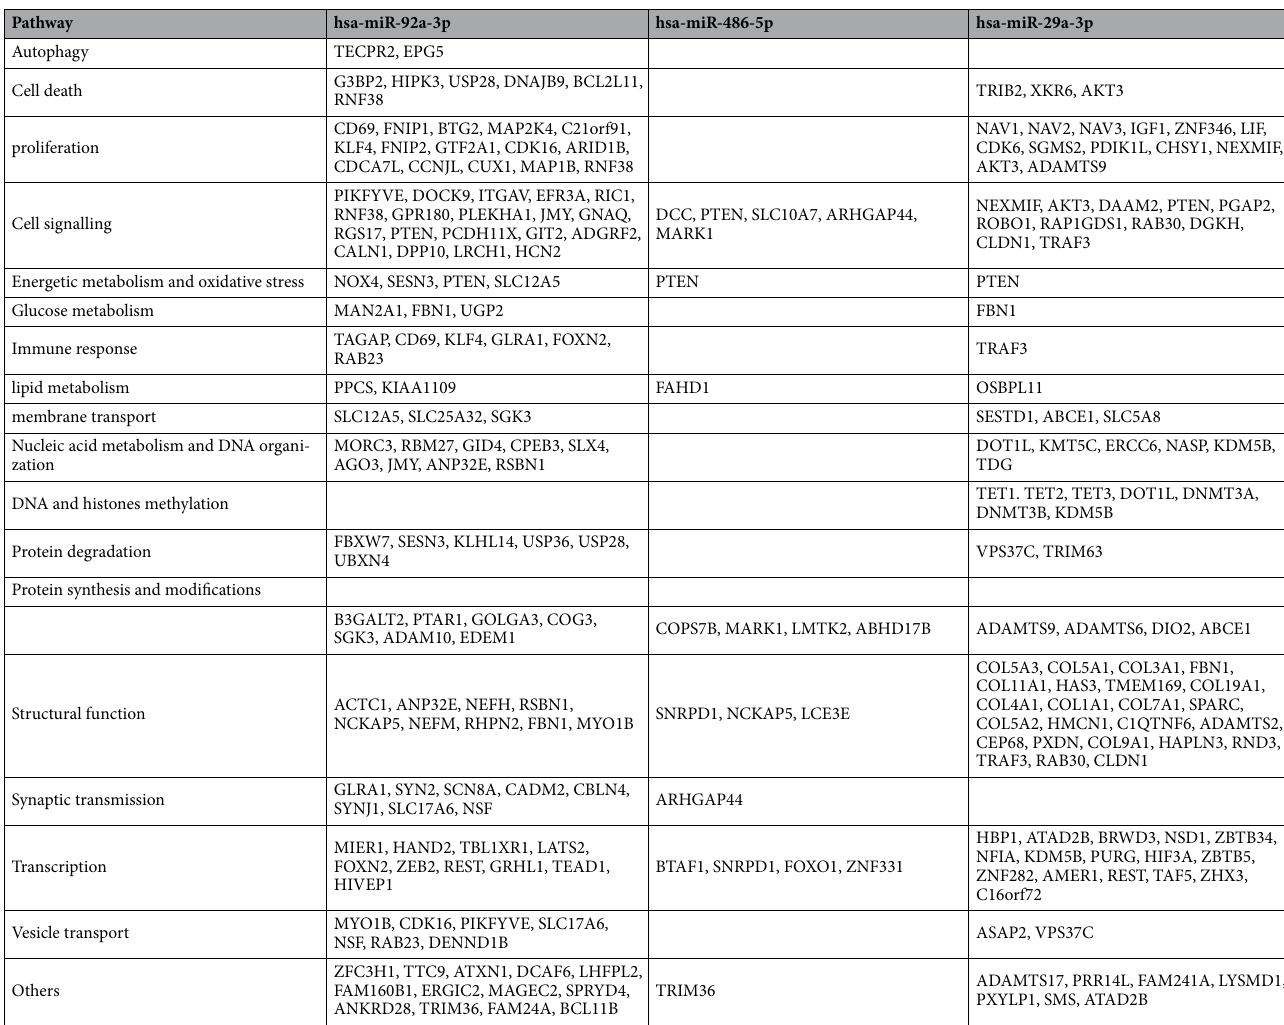
Table 4. Potential target genes and related AD pathways. In this link it can be found the full name of each gene (http:// mirdb. org/ mirdb/ index.